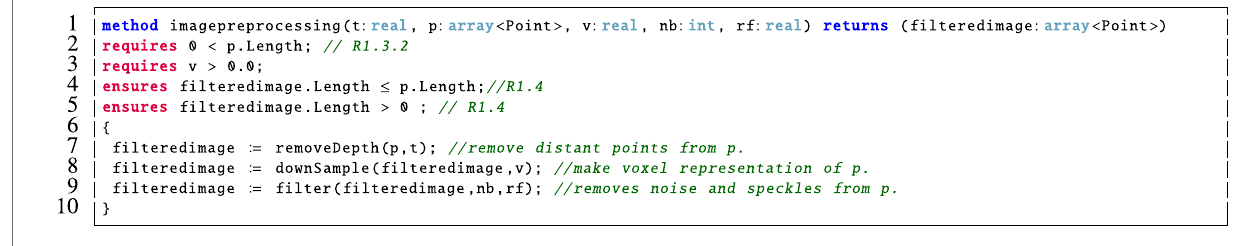
FIGURE6| Dafnymodelofthe imagepreprocessing componentshownin Figure1 .ThiswasoriginallypartofalargerDafnymodelin(Farrelletal.,2020)butit has since been refactored to conform to the system architecture described by the AADL model shown in Figure 1 .